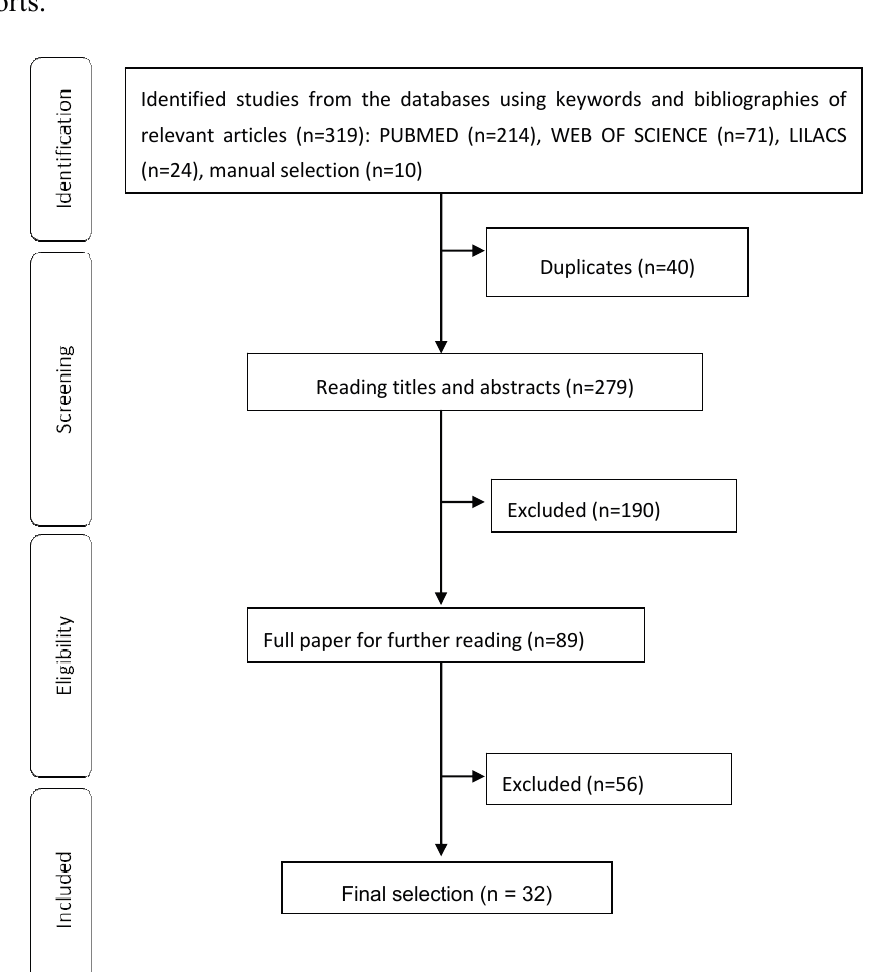
Figure 1. Flowchart of included studies. Studies were excluded according to the following exclusion criteria: studies in humans, studies of mixtures of substances or extracts from lichens, review articles, meta-analyses, abstracts, conference proceedings, editorials/letters, case